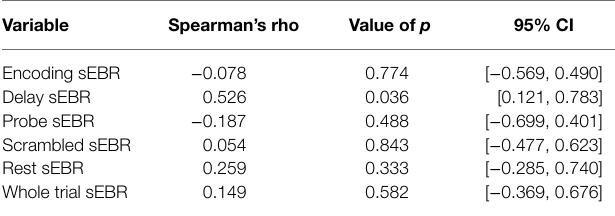
TABLE 3 | Correlations between sEBR and performance for Experiment 1. TABLE 4 | Correlations between sEBR and performance for Experiment